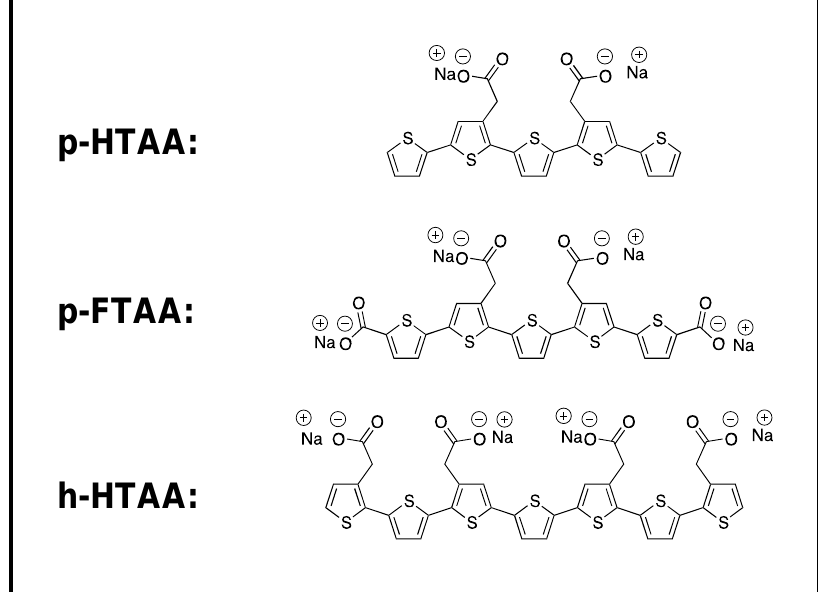
Figure 1. Chemical structures of LCO/LCP used in presented study: p -HTAA, p -FTAA, h